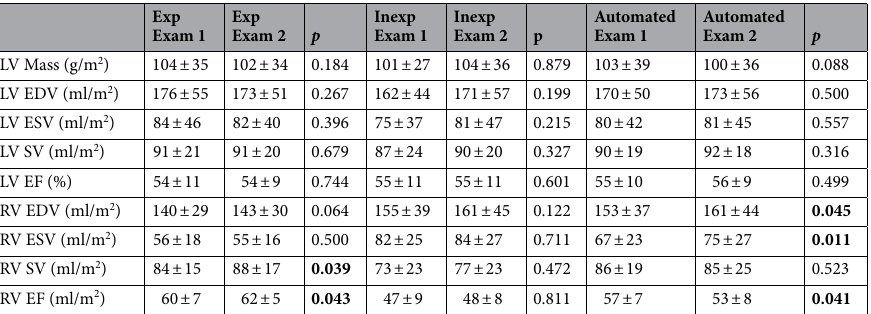
Table 1. Cardiac volumes. Cardiac volumes as assessed manually by the experienced (exp) and inexperienced (inexp.) observer as well as fully automated. Volumes are reported as mean ± standard deviation. LV mass is reported in gram, volumes in ml and EF in %. P -values in bold type indicate statistical significance < 0.05. LV left ventricular, RV right ventricular, EDV end-diastolic volume, ESV end-systolic volume, SV stroke volume, EF ejection